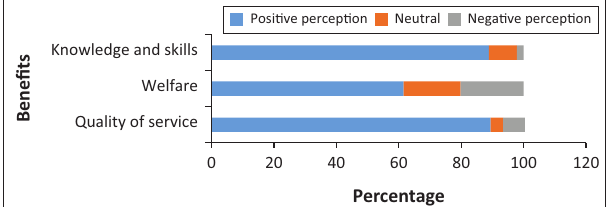
FIGURE 1: Driver views on benefits in regard to knowledge and skills, welfare and quality of service.